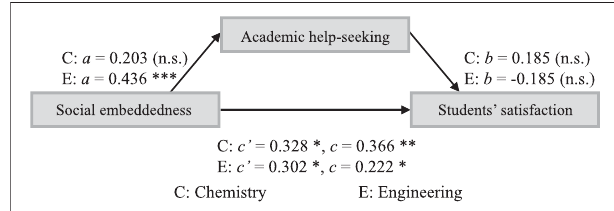
FIGURE 2 | Mediation model of the relationship between social embeddedness and student ’ s satisfaction via academic